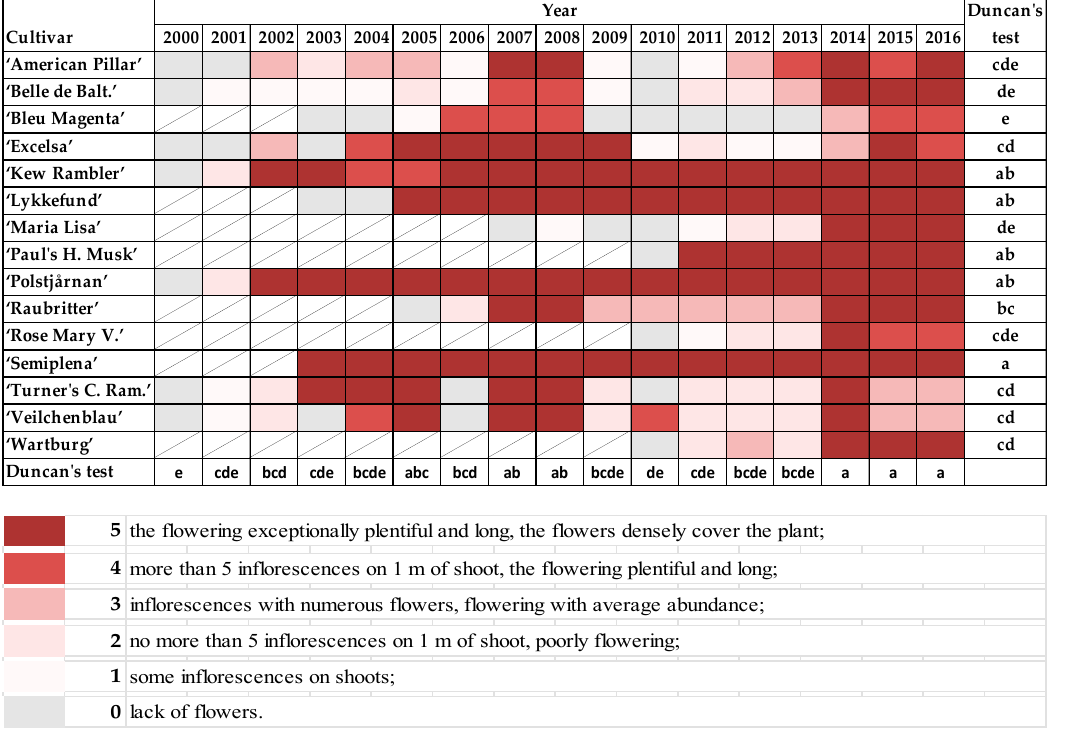
Figure 8. The abundance of flowering in rambler roses on the following scale: 0—lack of flowers; 1—some inflorescences on shoots; 2—no more than 5 inflorescences on 1 m of shoot, but flowering poorly; 3—inflorescences with numerous flowers, but flowering with average abundance; 4—more than 5 inflorescences on 1 m of shoot, plentiful and long flowering; 5—exceptionally plentiful and long flowering, the flowers densely cover the plant. Different letters indicate significant differences in the cultivars and the years. The Duncan’s test ( α = 0.05) was used. Table 6. The part of matrices of effect correlations between average monthly air temperature (2006, 2010, and 2016) and the start of the flowering period (BBCH 60 601) in rambler